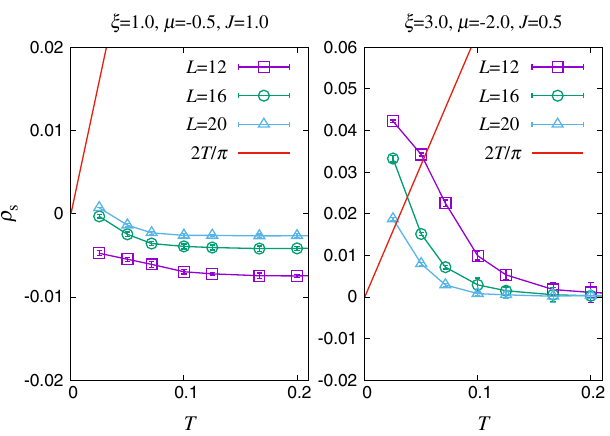
FIG. 13. Temperature dependence of ρ s at QCP for different system sizes and different